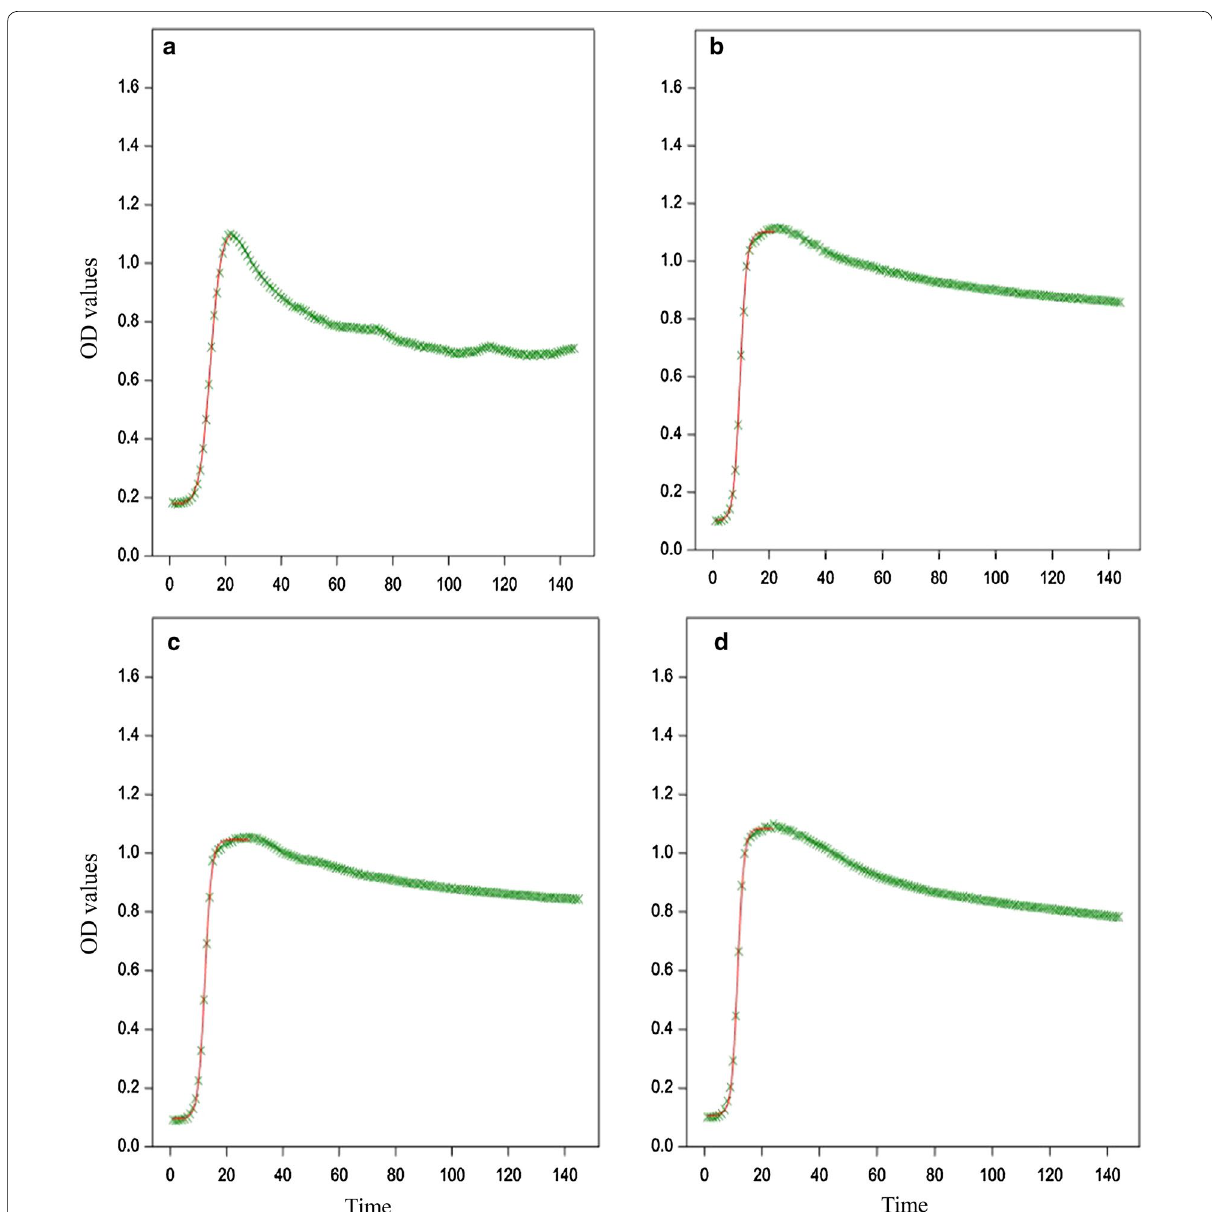
Fig. 1 Growth curves generated from the Bioscreen C for Lactobacillus curvatus (Arla-10), Enterococcus faecium (JFR-1), Lactobacillus paracasei subsp. paracasei (JFR-5), and Streptococcus thermophilus (TSB-8) at their optimal growth conditions for 48 h. Arla-10 strain was cultured in MRS broth, initial pH 7.4, at 37 °C ( a ); JFR-1 strain was cultured in BHI broth, initial pH 7.4, at 37 °C ( b ); JFR-5 strain was cultured in BHI broth, initial pH 7.4, at 37 °C ( c ); TSB-8 strain was cultured in BHI broth, initial pH 8.5, at 37 °C ( d ). *The OD value was measured and recorded by the Bioscreen C at 20-min interval. The numbers of 20, 40, 60, 80 100, 120 and 140 on the X axis represent that LAB has grown for 400, 800, 1200, 1600, 2000, 2400 and 2800 min,